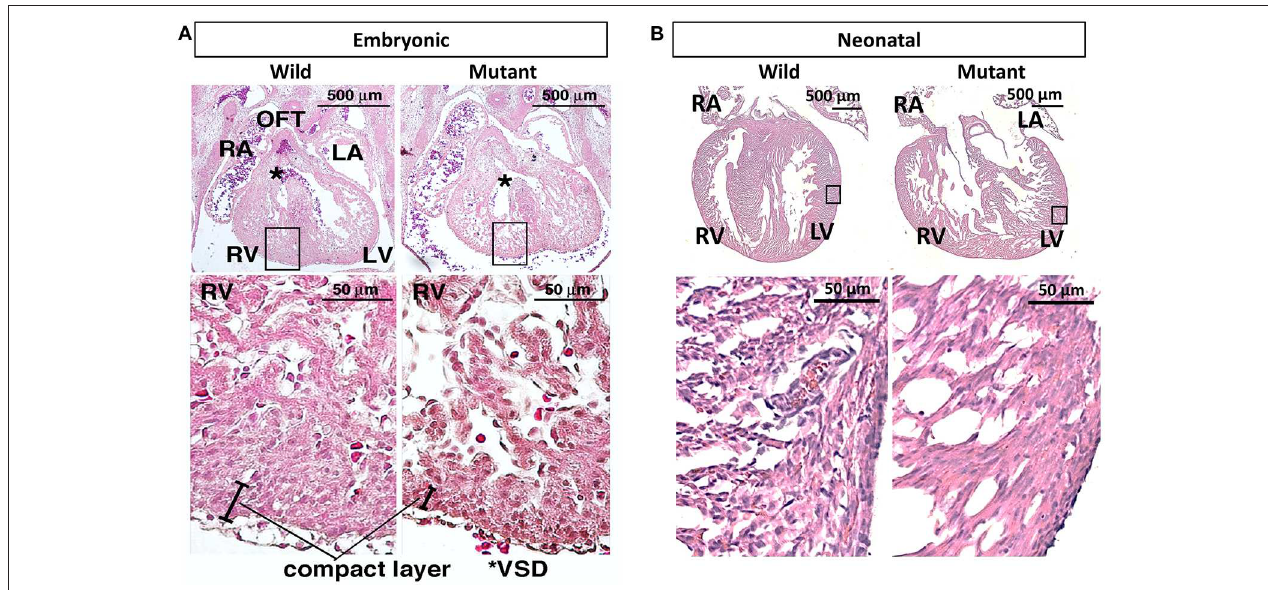
FIGURE 3 | Hematoxylin and eosin staining demonstrates ventricular noncompaction phenotype at both embryonic and neonatal ages in mutant Nkx2-5 mouse hearts (A) Embryonic heart and (B) neonatal heart hematoxylin and eosin staining demonstrating the ventricular noncompaction phenotype characteristic of mutant hearts. OFT, outflow tract; RA, right atrium; LA, left atrium; RV, right ventricle; LV, left ventricle; *VSD, ventricular septal